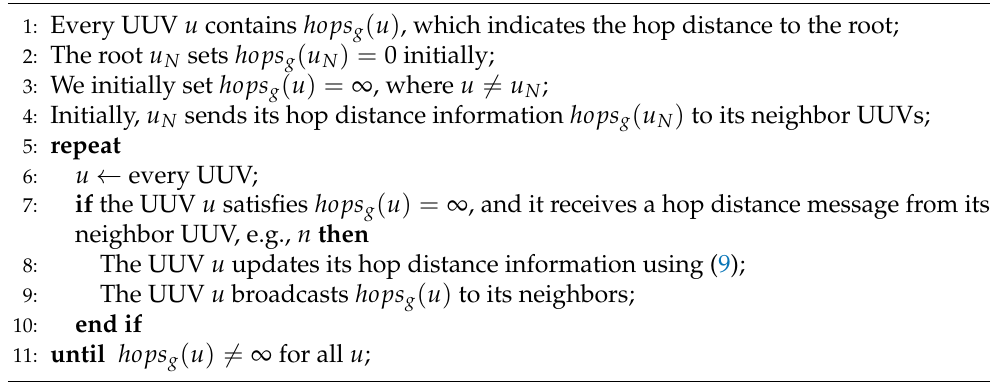
Algorithm 1 Distributed BFS algorithm to generate a spanning tree